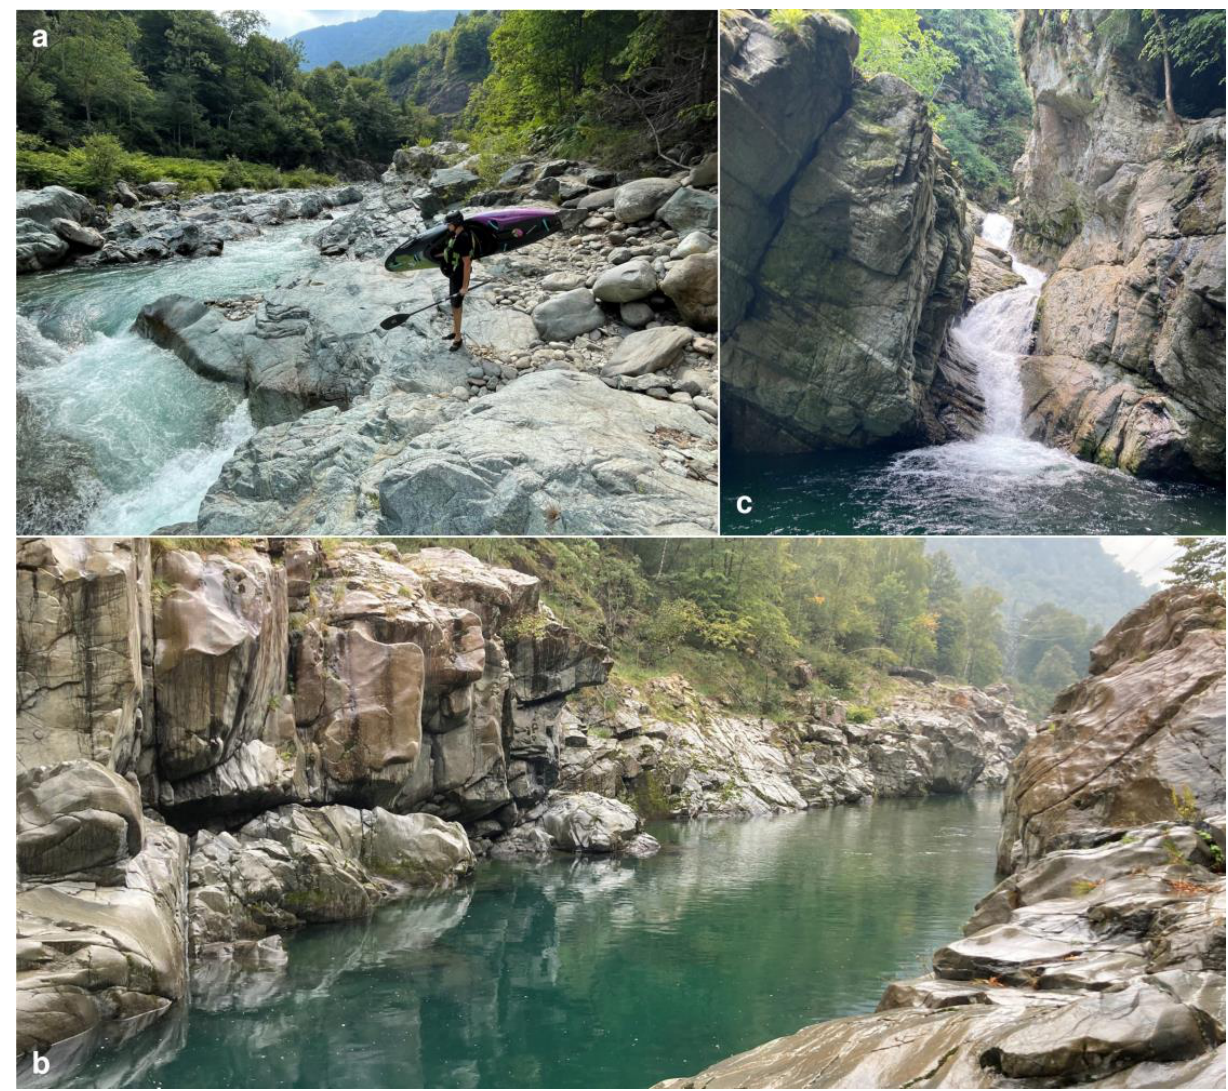
Figure 4. Bedrock outcropping along the Gole del Sesia ( a — GS), Classico del Sesia ( b — CS), and Canyoning Sorba ( c — CNS) segments. ( a ) Amphibolite gabbro along the Gole del Sesia (GS-G-B; courtesy of M. Depicolzuane, 2022); ( b ) Peridotite of the Balmuccia gorge immediately up valley to the start of the Classico del Sesia (CS-G-A), with an evident straight pattern; ( c ) Minuti Gneiss incised along the Devil Slide of Canyoning Sorba (CNS-G-A). For abbreviations, please see Section 3.1.